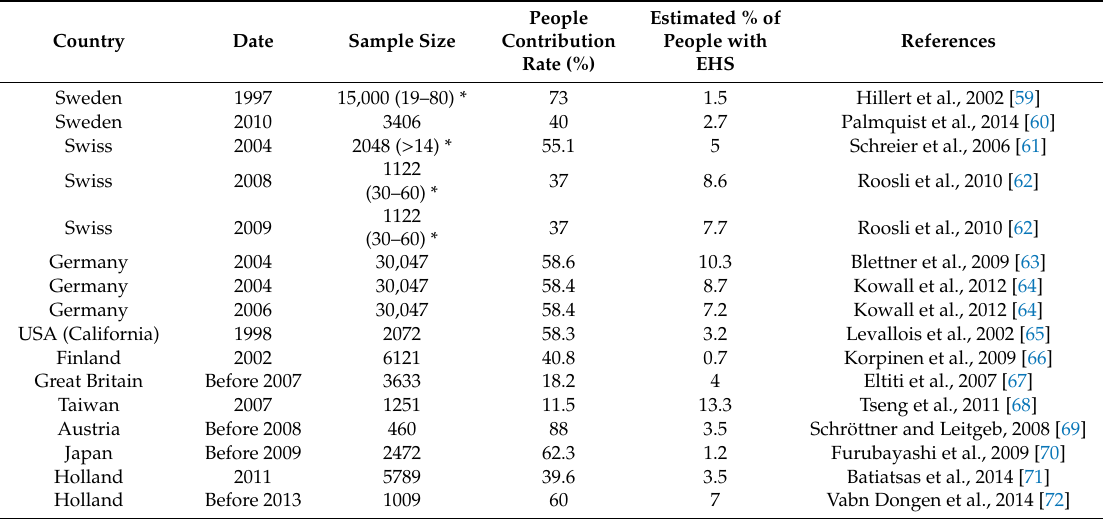
(Table 10), meaning that millions of people may in fact be a ff ected by EHS worldwide. Table 10. Estimated prevalence of people with self-reported EHS in di ff erent worldwide countries. USA—United States of America.